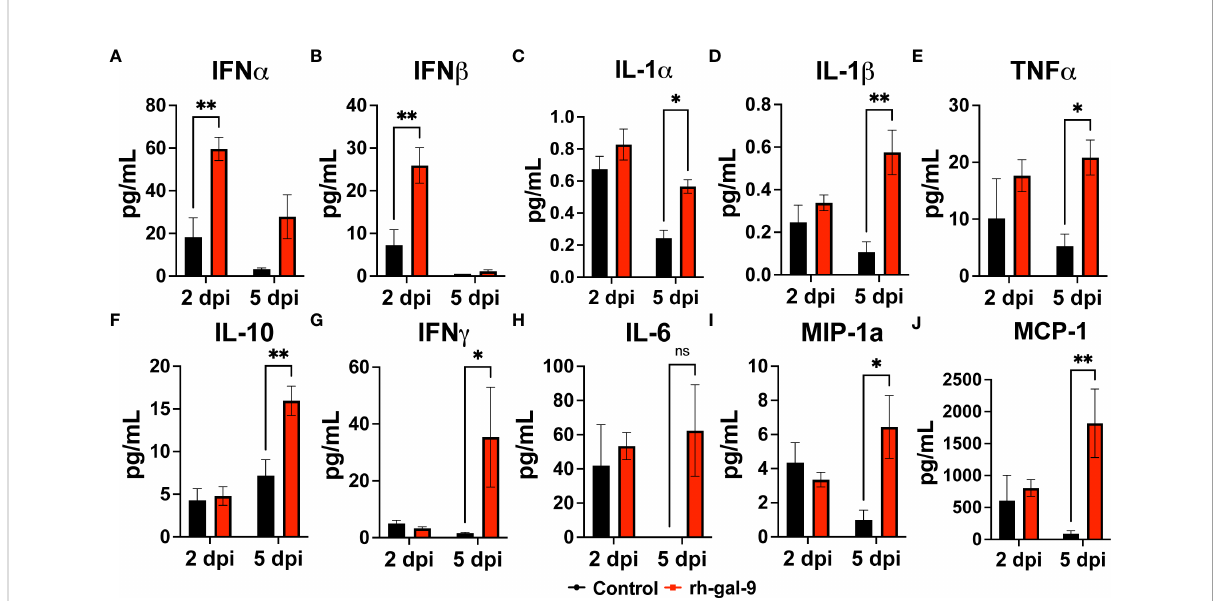
FIGURE 6 rh-gal-9 treatment increases Type 1 IFN and MyD88 cytokines and chemokines in the BALF. (A, B) Type 1 interferon (A) IFN g and (B) IFN b , (C-H) MyD88 Cytokines (C) IL-1 a , (D) IL-1 b , (E) TNF a , (F) IL-10, (G) IFN g , H) IL-6, and (I, J) Chemokines (I) MIP-1 a and (J) MCP-1 at 2- and 5- dpi of PBS (black) or rh-gal-9 (red) treated mice. n=4/group, *p<0.05, and **p<0.01, Two-way ANOVA with Sidak Correction. Data are represented as mean +/-